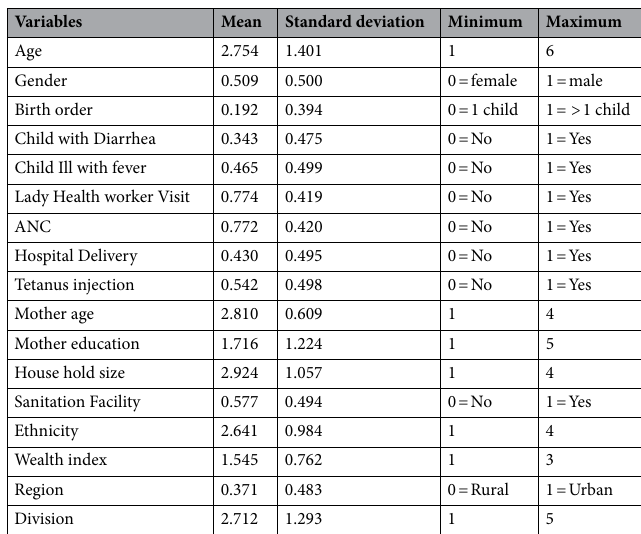
Table 1. Mother’s socio-demographic and economic characteristics (n = 7781)-Full